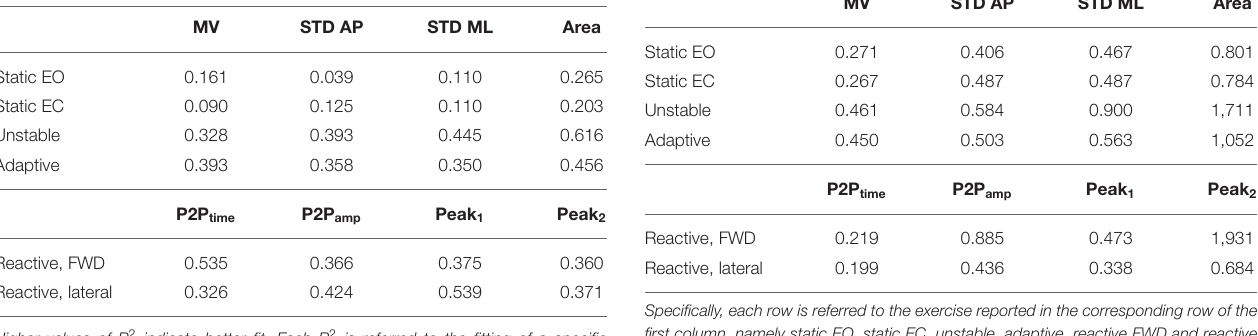
TABLE 2 | Goodness of fit, R 2 , for the second order curve that fits a postural parameter P i , expressed as function of age.